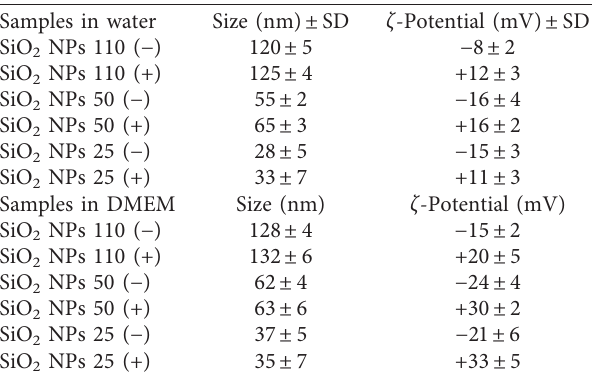
Figure 5: Representative TEM images of green SiO 2 NPs at two different magnifications, (a) scale bar 100nm and (b) scale bar 50nm, and the related diffraction figures (c). Statistical analysis with Gaussian fit (blue line) (d). Table 1: Characterization of SiO Table 2: Characterization in water and DMEM of SiO − ), SiO 2 NPs 110 ( 2 NPs 110 (+) SiO 2 NPs 50 ( − ), SiO 2 NPs 50 (+), SiO 2 NPs 25 ( − ), and SiO 2 NPs 25 (+) in water and DMEM by DLS and ζ -potential measurements.